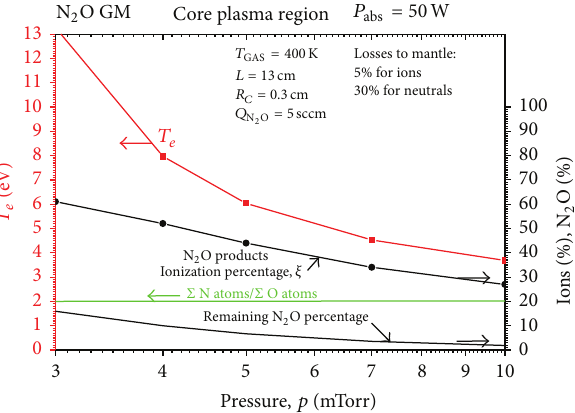
Figure 4: Comparison of 𝑇 𝑒 , 𝑛 𝑒 , and ionized species percentage for N 2 O and Ar in the “core” region of a HPT of 50 W absorbed power. Pressure varies from 3mTorr to 10mTorr.